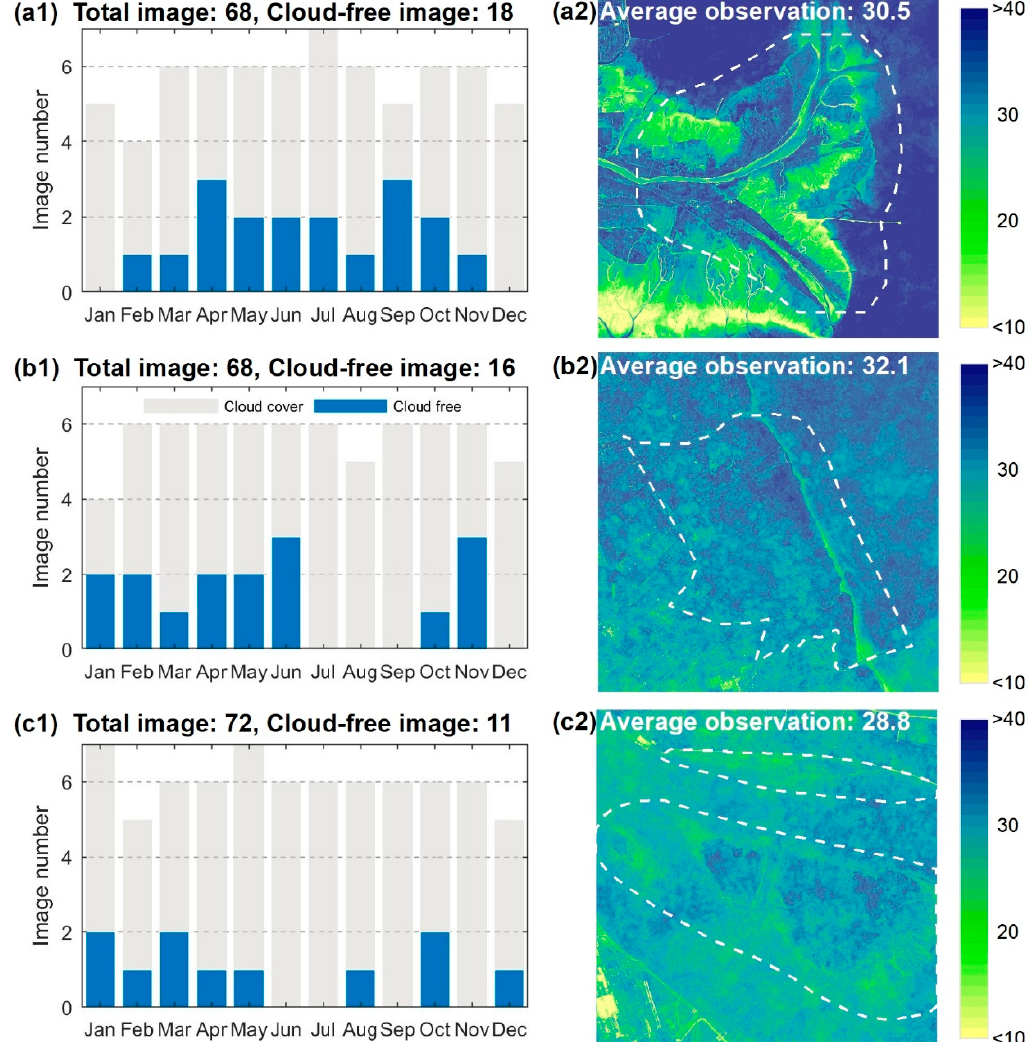
Figure 2. Improvements in the number of available observations from the pixel-di ff erential time series. ( a1 – c1 ) Temporal distribution patterns of available observations from cloud-free images for the YRD, JMC, and YRE, respectively; ( a2 – c2 ) spatial distribution pattern of available observations from the pixel-di ff erential time series for the YRD, JMC, and YRE, respectively.